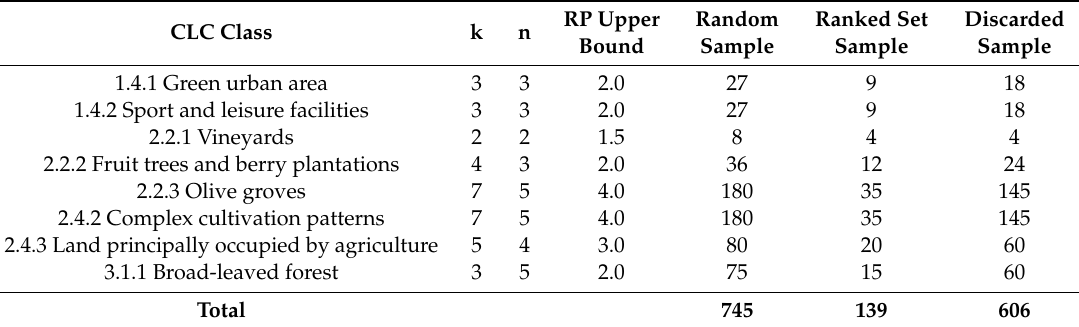
Table 3. RSS design parameters for the populations belonging to the CLC classes. k is the number of ranks (or sets); n is the number of cycles; RP is the relative precision of the estimator of the mean for RSS relative to the usual estimator for simple random sampling; the random sample is the sample size randomly drawn in each population; the ranked set sample is the sample size selected under RSS; and the discarded sample is the sample size that was discarded after selection and